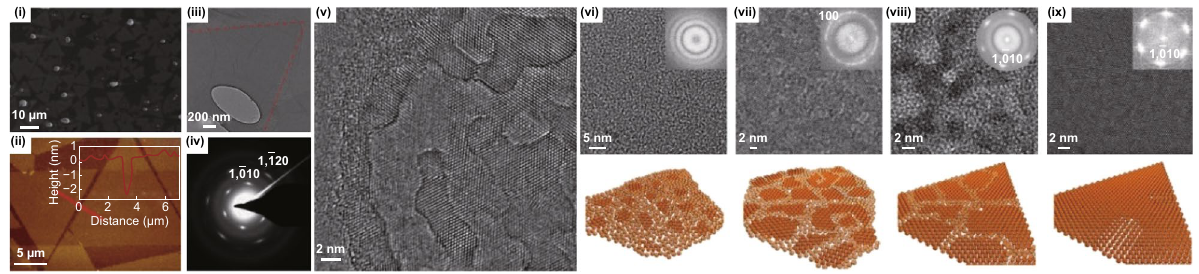
Fig. 10 Large-area synthesis of 2D ZnO. (i) SEM image, ( ii ) AFM height profile, ( iii ) TEM, ( iv ) corresponding SAED pattern is shown in iii, ( v ) HRTEM image of ZnO nanosheet showing overlayer growth. ( vi – ix ) TEM images and graphic illustrations are showing the time-dependent evolution of ZnO nanosheets. Fast Fourier transform (FFT) patterns of the TEM images are at the insets, respectively. The amorphous area was entirely crystallised, and the nanosheet became single-crystalline over different reaction time. Adapted with permission from Ref. [49]. Copy- right 2016, Nature Publishing Group